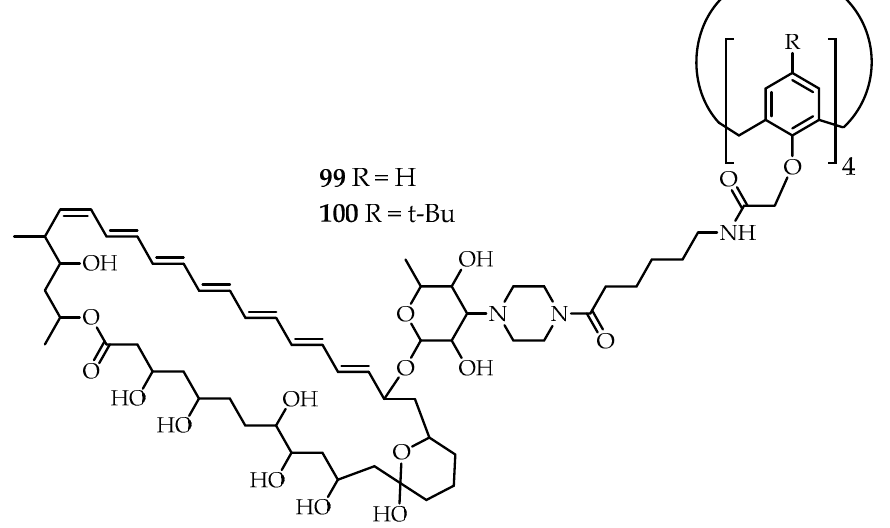
Figure 11. Structures of macrocycles 99 - 100 .